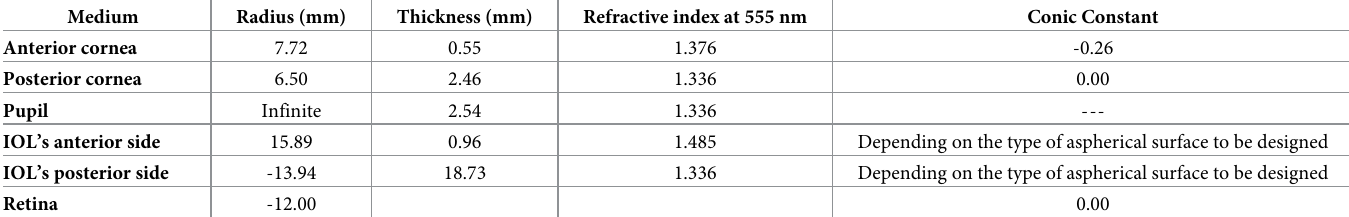
Table 1. Navarro’s eye model parameters used for the IOLs design and simulation. Medium